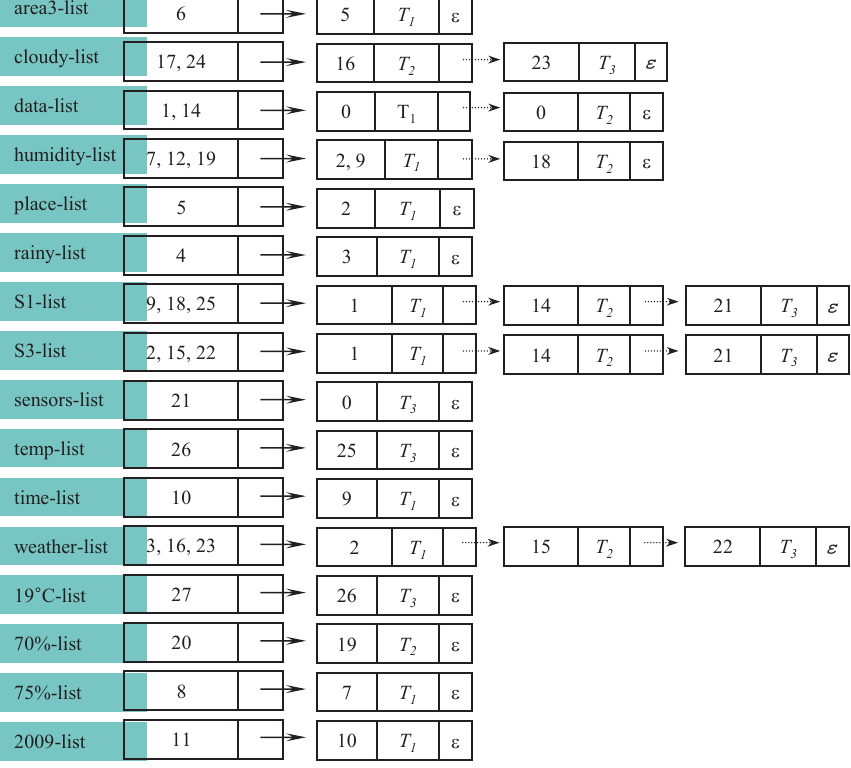
Figure 5. Assembling label lists into L